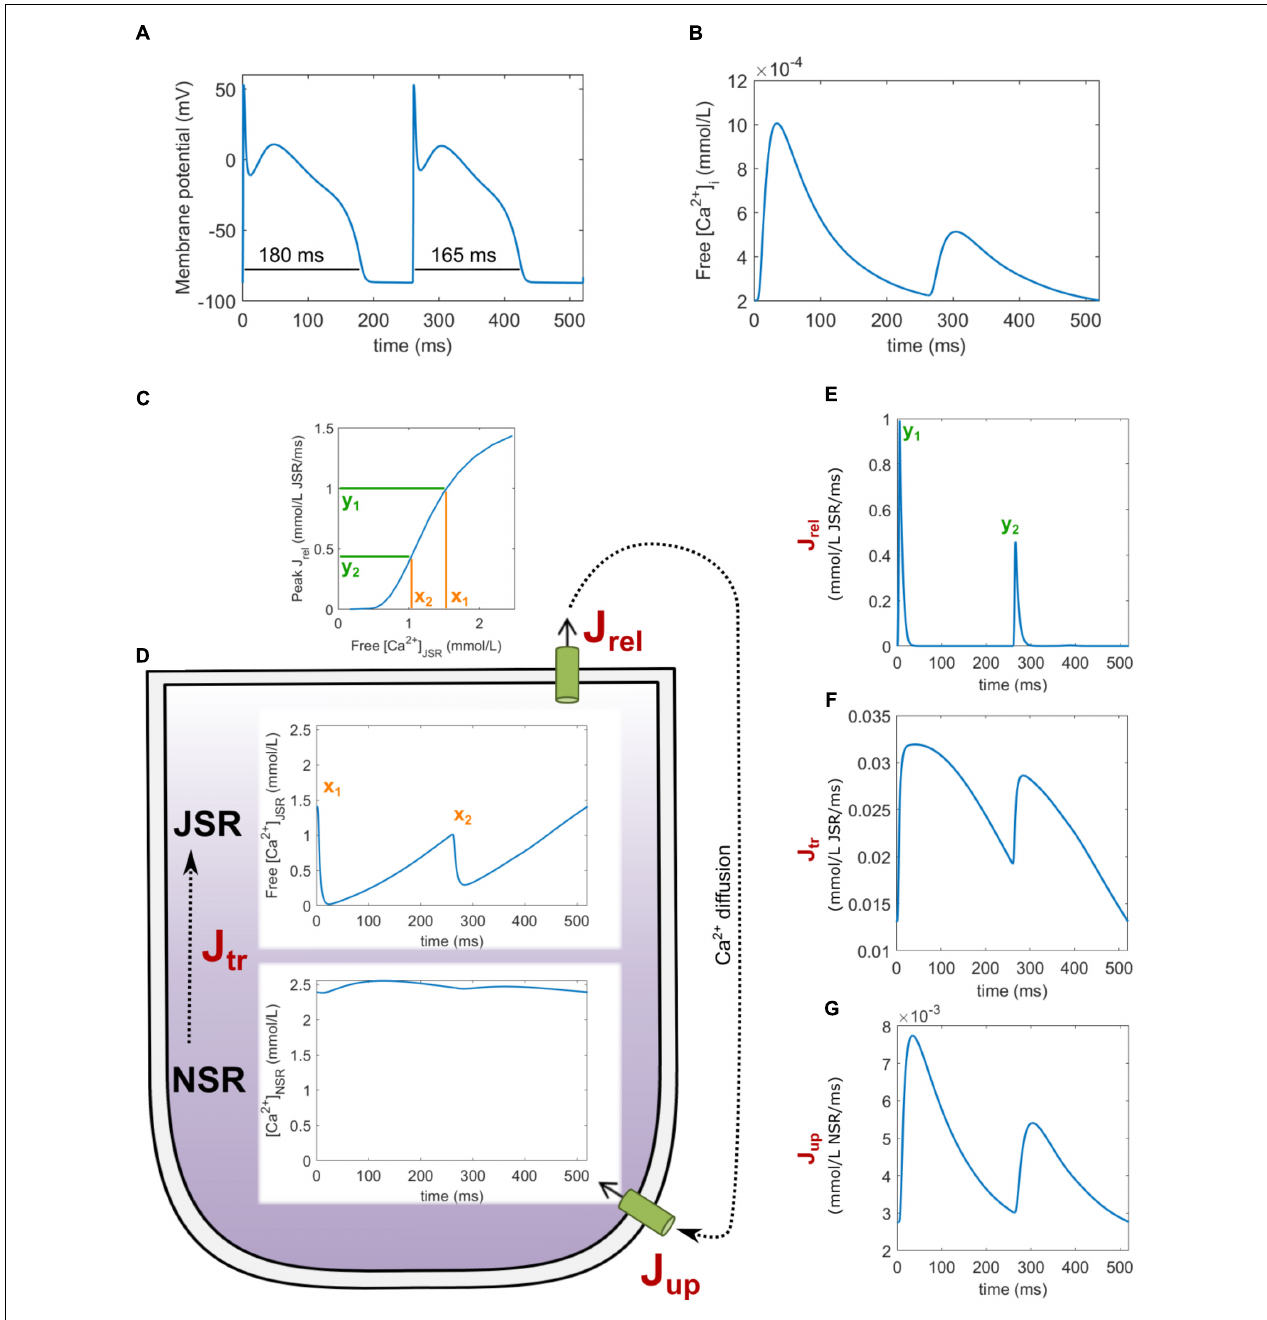
FIGURE 5 | An overview of key variables during alternans in the HeRd model. Two action potentials after reaching the stable state are shown, starting with a prolonged action potential (A) with underlying large calcium transient (B). (C) The relationship between free JSR calcium and peak J rel . (D) Free JSR calcium and NSR calcium. Fluxes associated with SR shown are J rel (E) , J tr (F) , and J up (G) . The free Ca 2 + [ JSR ] levels x 1 , x 2 and peak release values y 1 , y 2 are linked with load–release